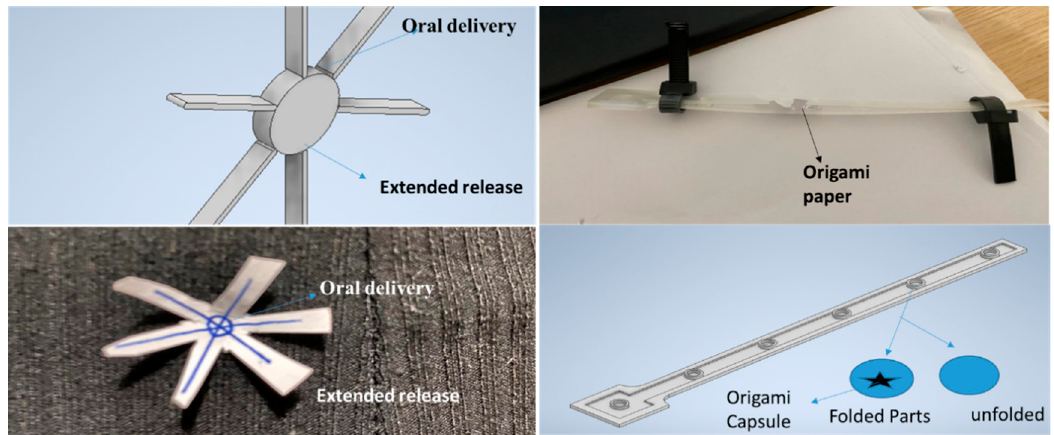
Figure 17. Demonstration of the concept of the proposed “origami” healing mechanism.